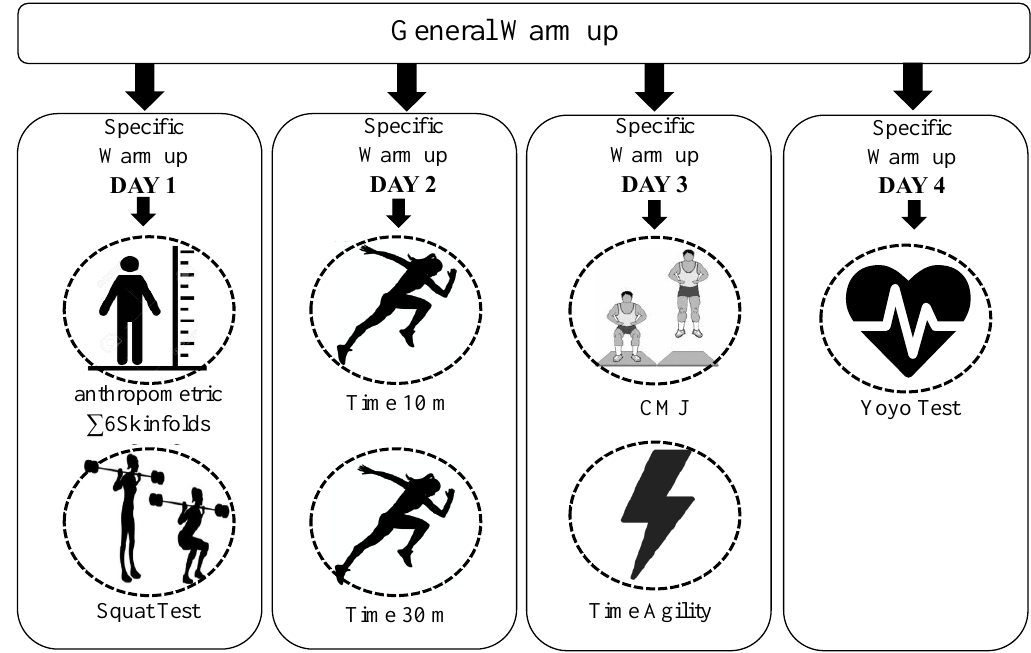
Figure 1: Distribution of anthropometric and physical condition evaluations